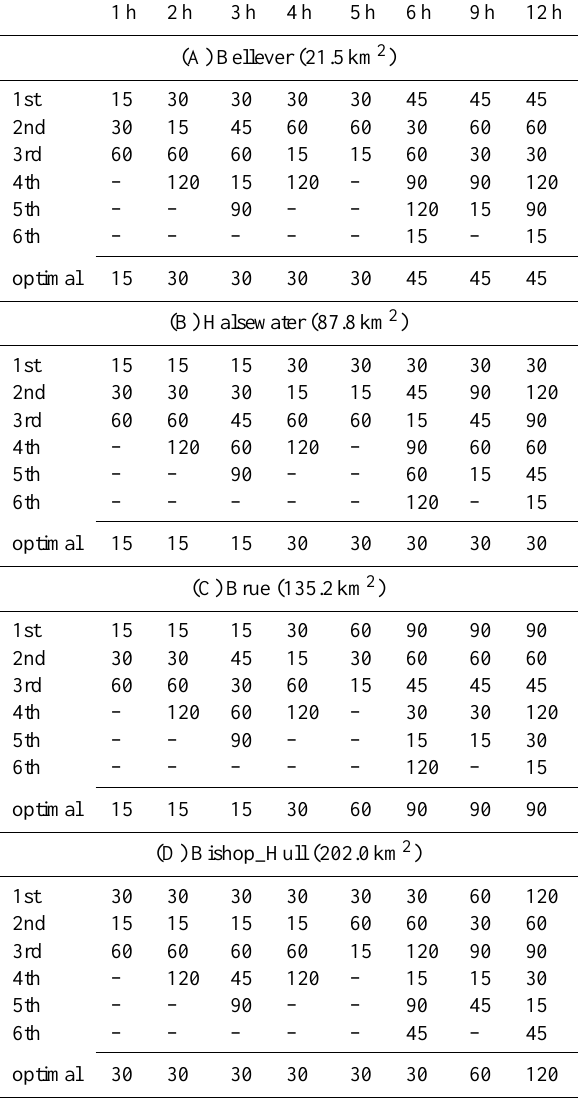
Table 8. Rankings of different time intervals according to the fore- casting results (RMSE) with a certain lead time (from the lowest to the highest RMSE). The optimal time intervals (ranked as the 1st) are